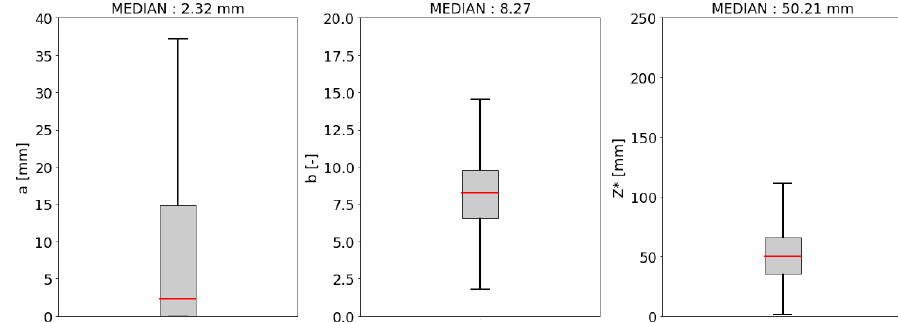
Figure A6. Boxplot showing the calibrated values of the parameters a , b , and Z ∗ over the Murray–Darling basin.